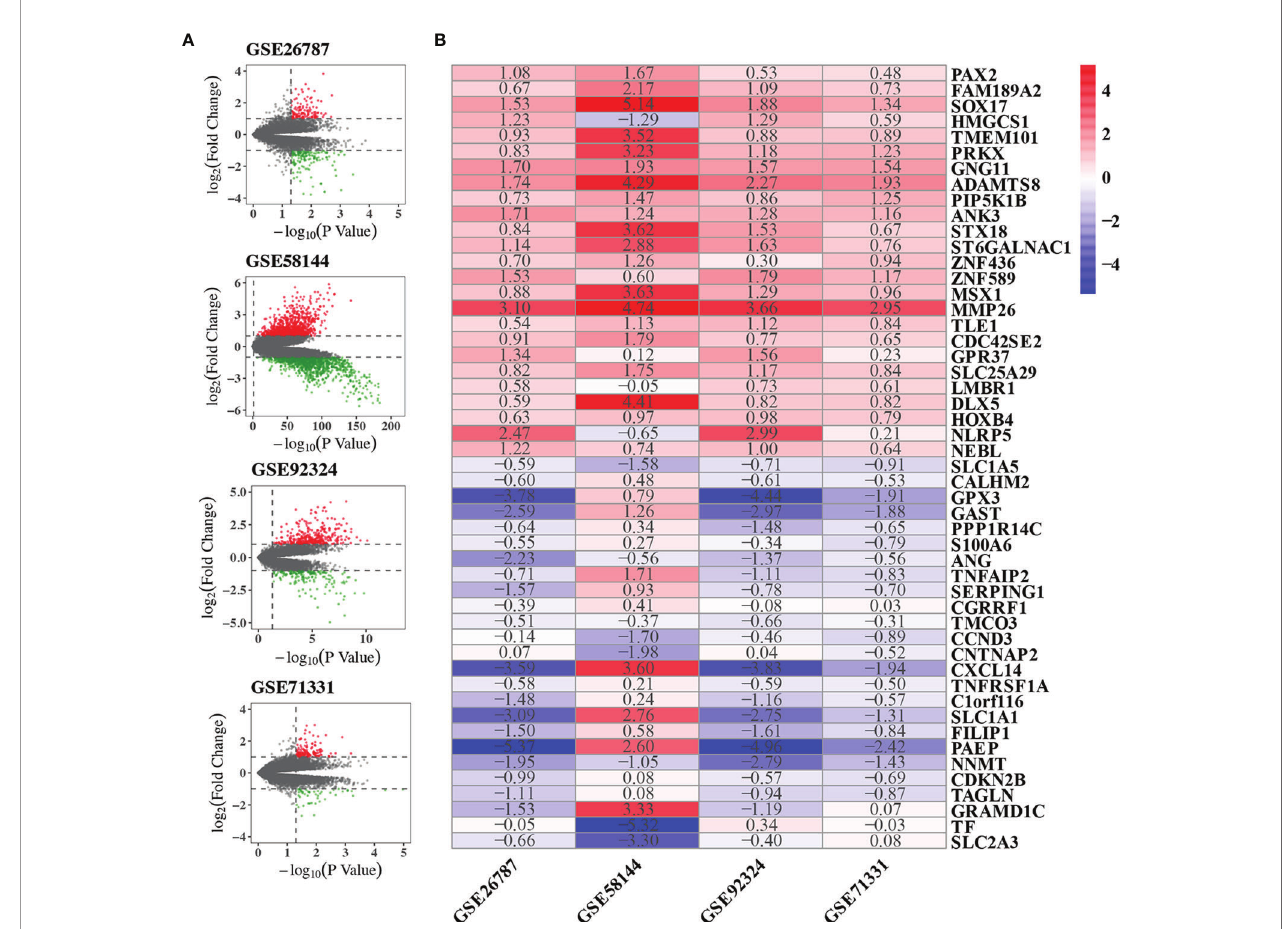
FIGURE 2 | Results of RRA analysis. (A) Volcano plots showing DEGs of the four microarrays. Red points represented signi fi cantly up-regulated genes, while green points represented signi fi cantly down-regulated genes, grey points represented genes without signi fi cant difference. The criteria of DEG is |logFC|>1 and p- value<0.05. (B) Heatmap showing the top 25 up-regulated and 25 down-regulated robust DEGs in the RRA analysis. The number in box represents the log2FC. Red color denotes up-regulation, blue color denotes down-regulation, the color from dark to light represents the fold change from large to